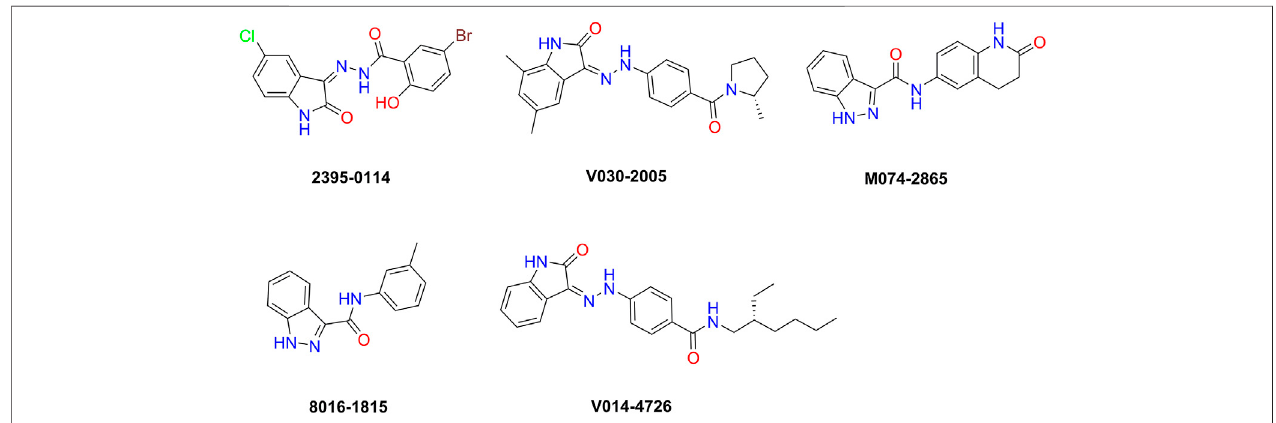
Supplementary Figure 2 . The physical characteristics and docking